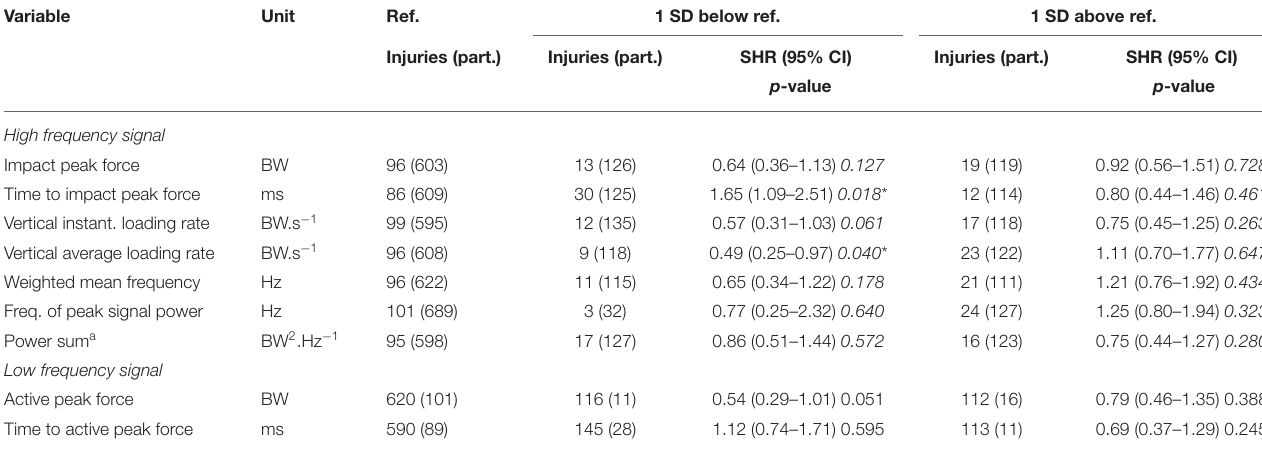
TABLE 3 | Unadjusted competing risk regression models for the association between force characteristics of the high and low frequency signals and running-related injury risk ( n = 848). Variable Unit Ref. 1 SD below ref. 1 SD above ref. Injuries (part.) Injuries (part.) SHR (95% CI) Injuries (part.) SHR (95% CI) p -value p